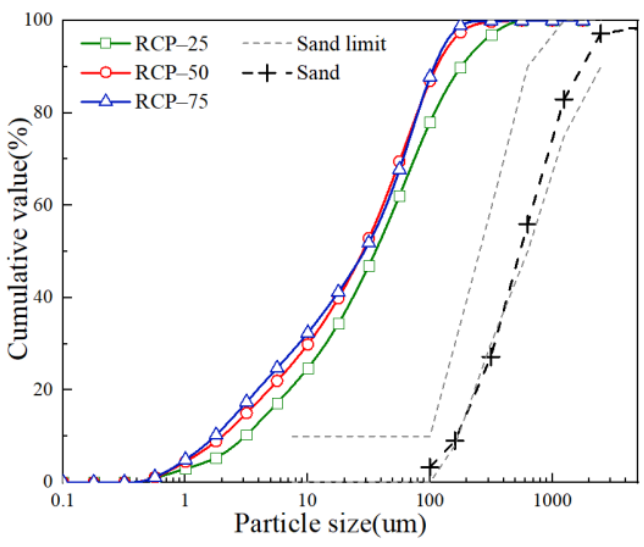
Figure 1. Particle size distribution for RCP and fine aggregate.